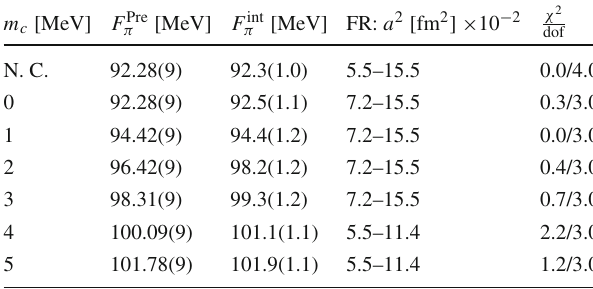
Table 21 The prediction of the pion decay constant F Pre π , interpolated results of the pion decay constant F int π , and fitting